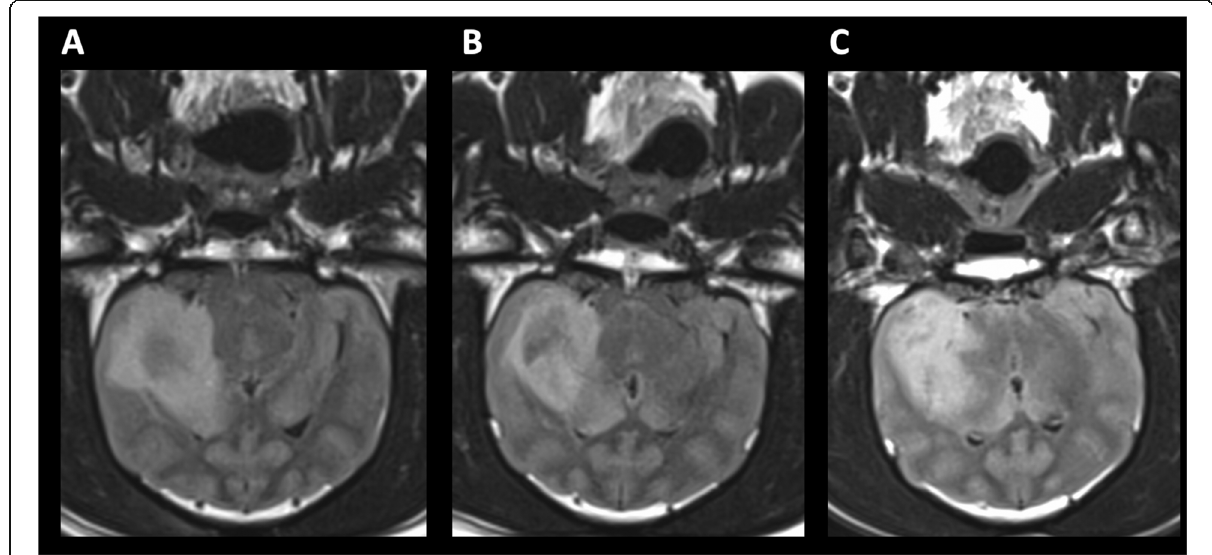
Fig. 8 P4 T2 FLAIR at a 1 month pre-treatment, b 1 month post-treatment, and c 6 months